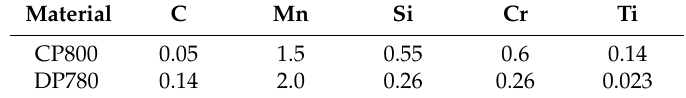
Table 1. The percentage of chemical compositions of the CP800 and DP780 steels.